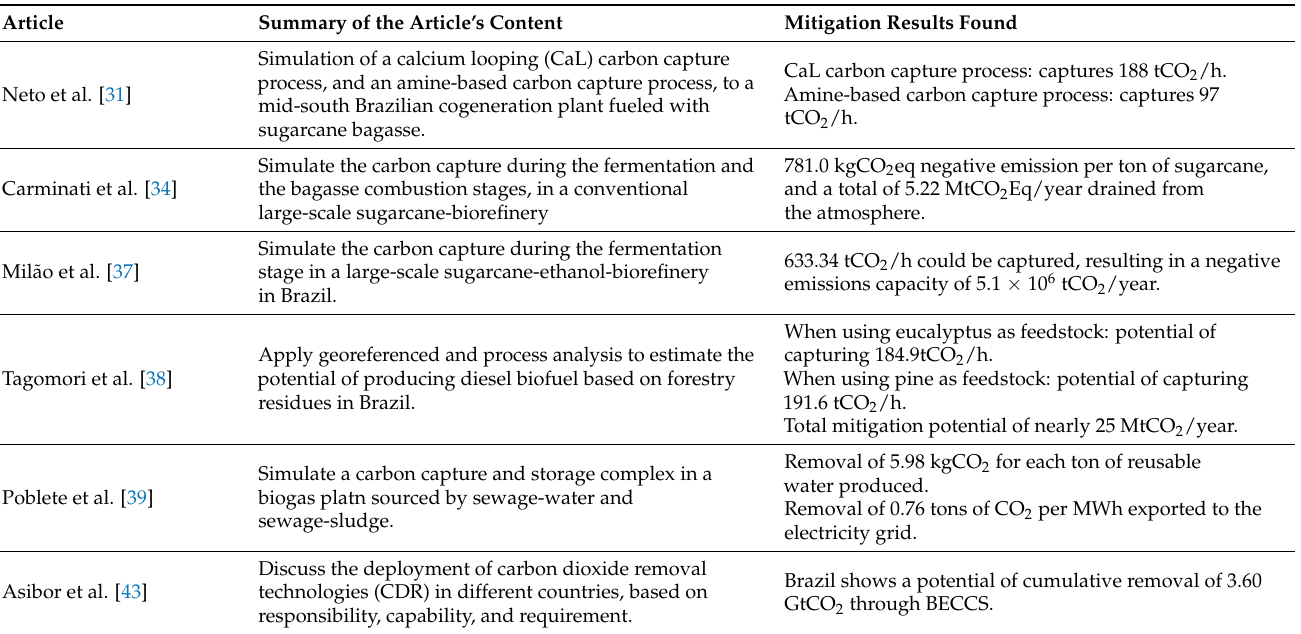
Table 4. Summary of articles that evaluated the CO 2 mitigation potential of implementing BECCS in